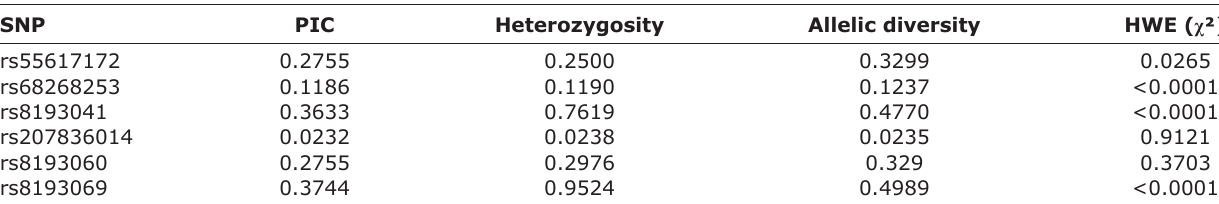
Table-4: PIC, heterozygosity and HWE and probability distribution in total resource population of cattle. SNP